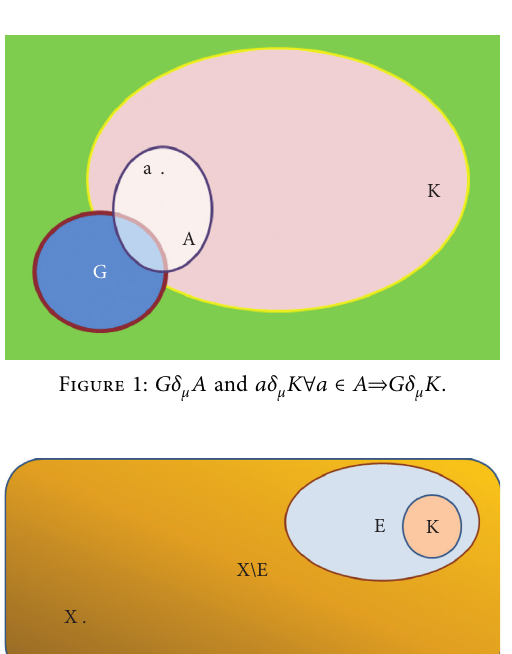
K ⇒ x δ E and ( X ∖ E ) δ μ μ